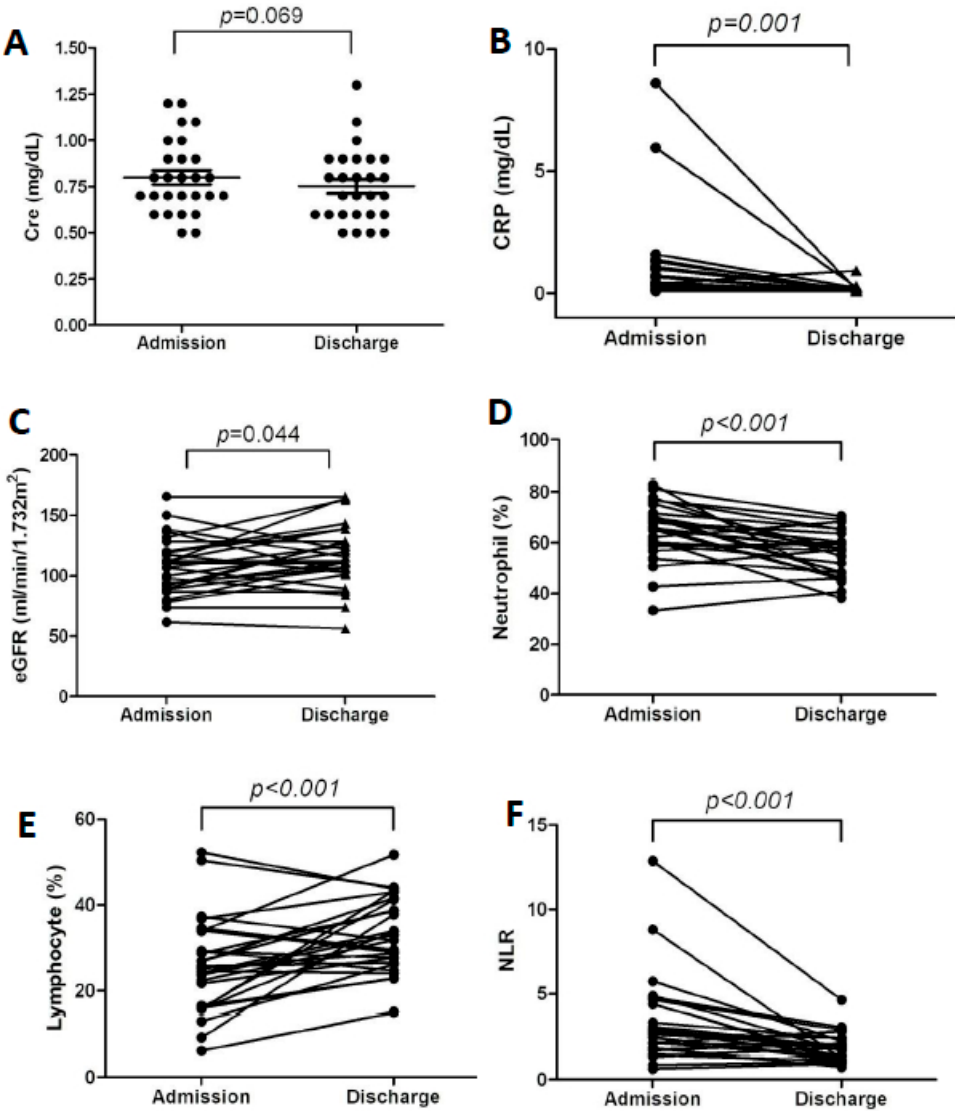
Figure 1. Comparison of data collected upon hospital admission and discharge. ( A ) Serum creatinine. ( B ) CRP level. ( C ) eGFR. ( D ) Neutrophil count. ( E ) Lymphocyte count. ( F ) Neutrophil-to-lymphocyte ratio.